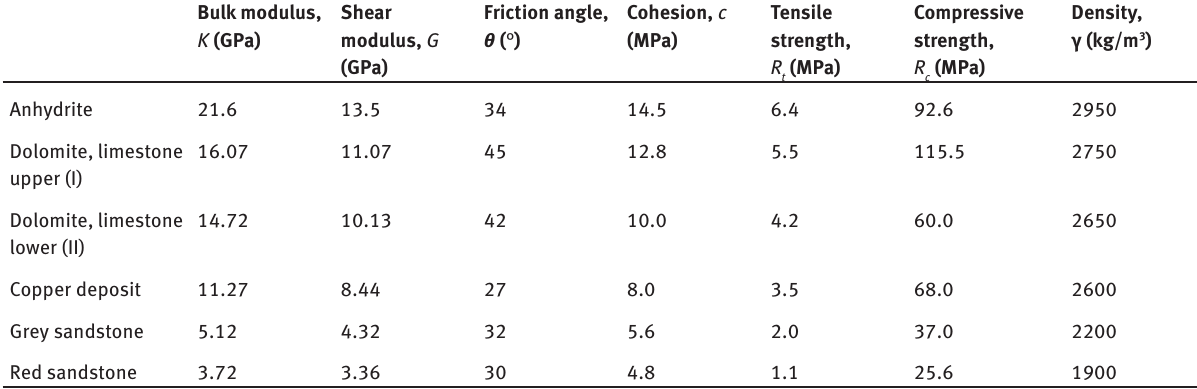
Table 2: Mechanical parameters of intact rocks in the A5